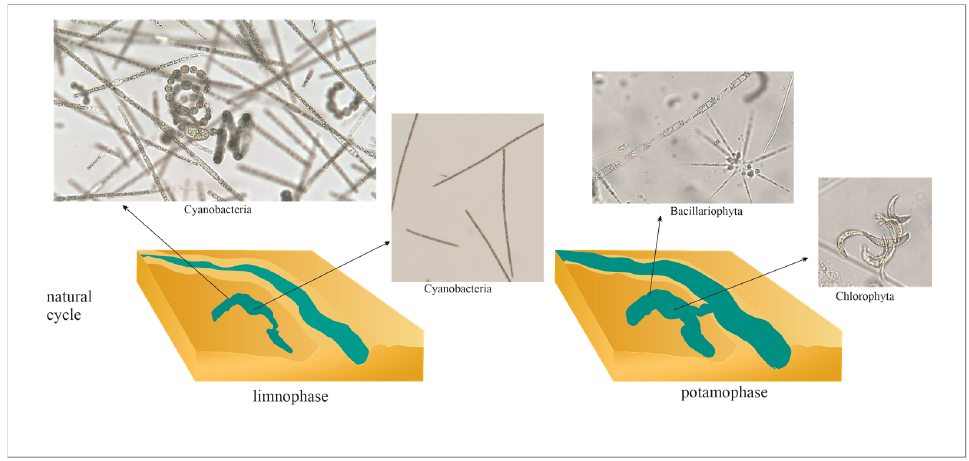
Figure 2. Common groups of phytoplankton in the limnophase and potamophase